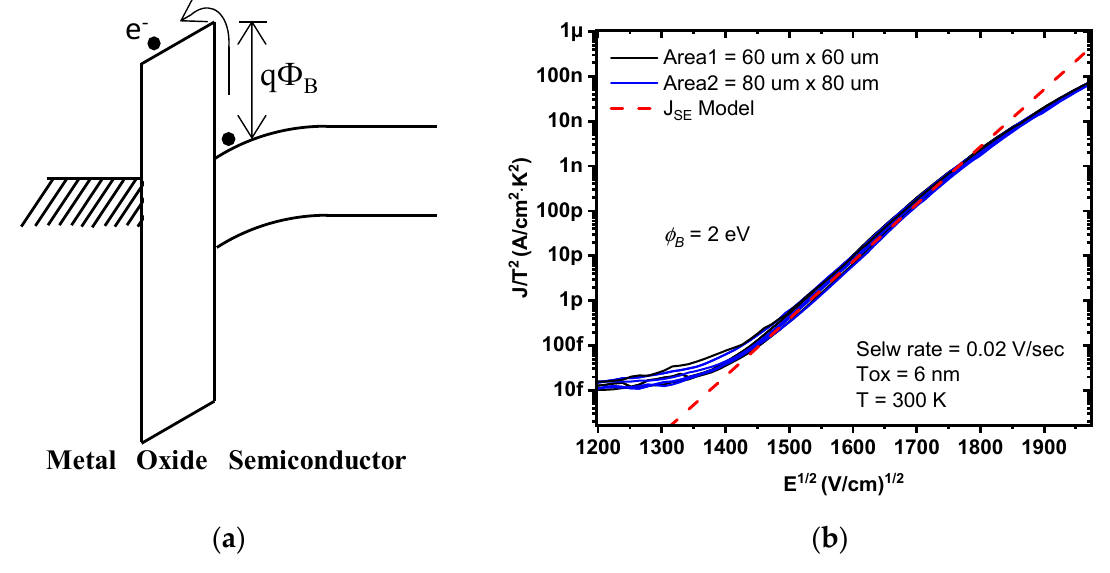
Figure 5. a) Band energy diagram for Schottky emission, and b) comparison of Figure 5. ( a ) Band energy diagram for Schottky emission, and ( b ) comparison of J / T 2 vs. E 1/2 curves J/T 2 vs E 1/2 curves for measured data and Schottky model. for measured data and Schottky